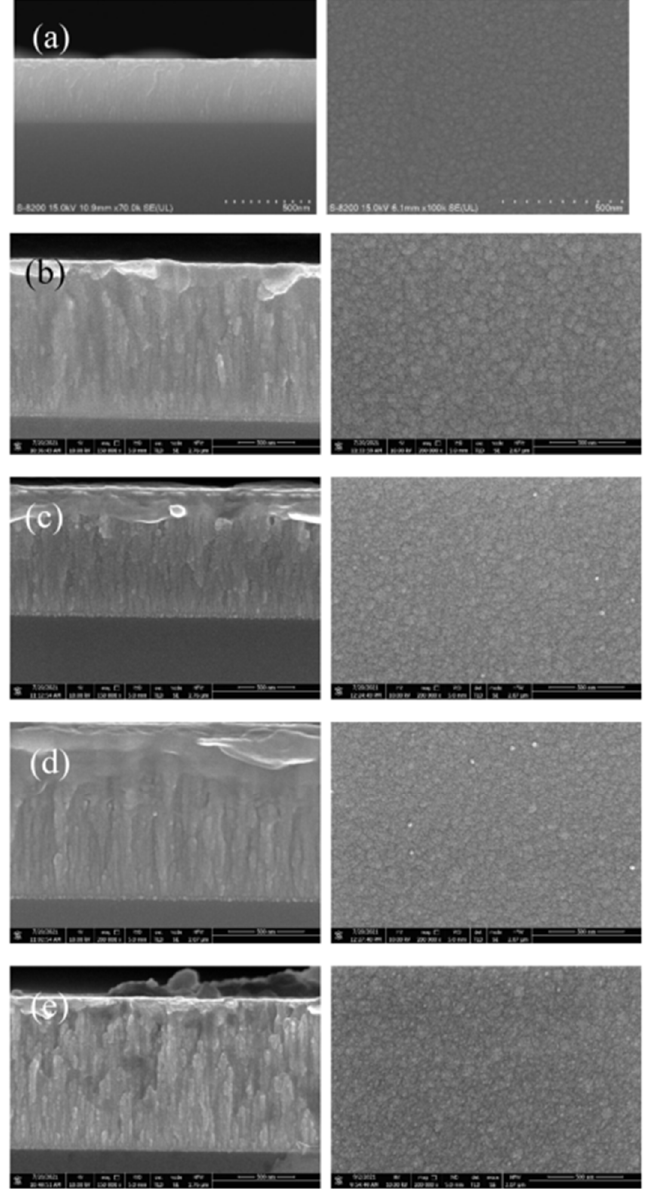
Figure 7. Cross-sectional SEM (left) and plane-view SEM micrographs (right) of AlCu x NiTiZr 0.75 films: ( a ) AlCuNiTiZr 0.75 , ( b ) AlCu 1.4 NiTiZr 0.75 , ( c ) AlCu 2 NiTiZr 0.75 , ( d ) AlCu 2.4 NiTiZr 0.75 , ( e ) AlCu 2.8 NiTiZr 0.75 . Reprinted with permission from [14]. 2022, Elsevier.